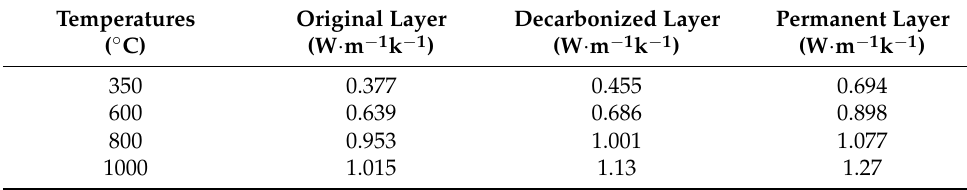
Table 4. The conditions of the burner nozzle.